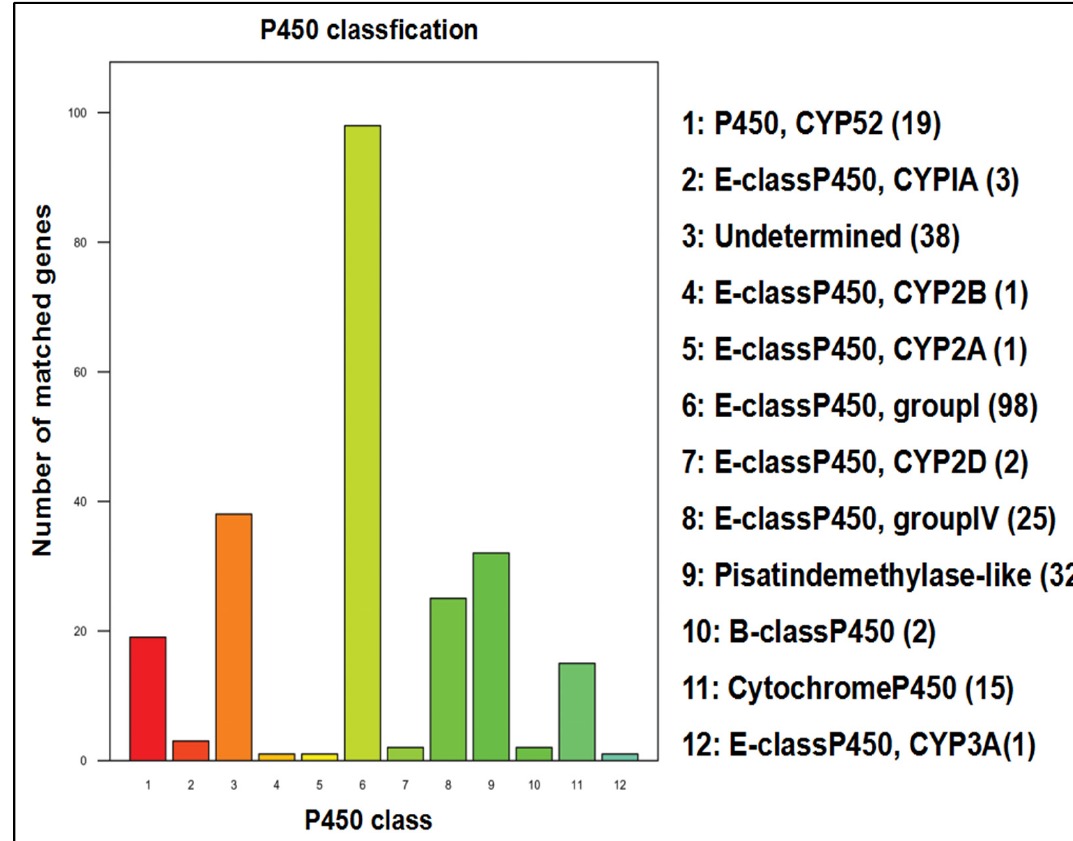
Figure 4. Functional classification of cytochrome P450 in the A. rasikravindrae genome. In this figure, the x -axis shows the P450 class, y -axis represents the number of matched genes with a scale from 0–100. P450 classification includes 12 classes.